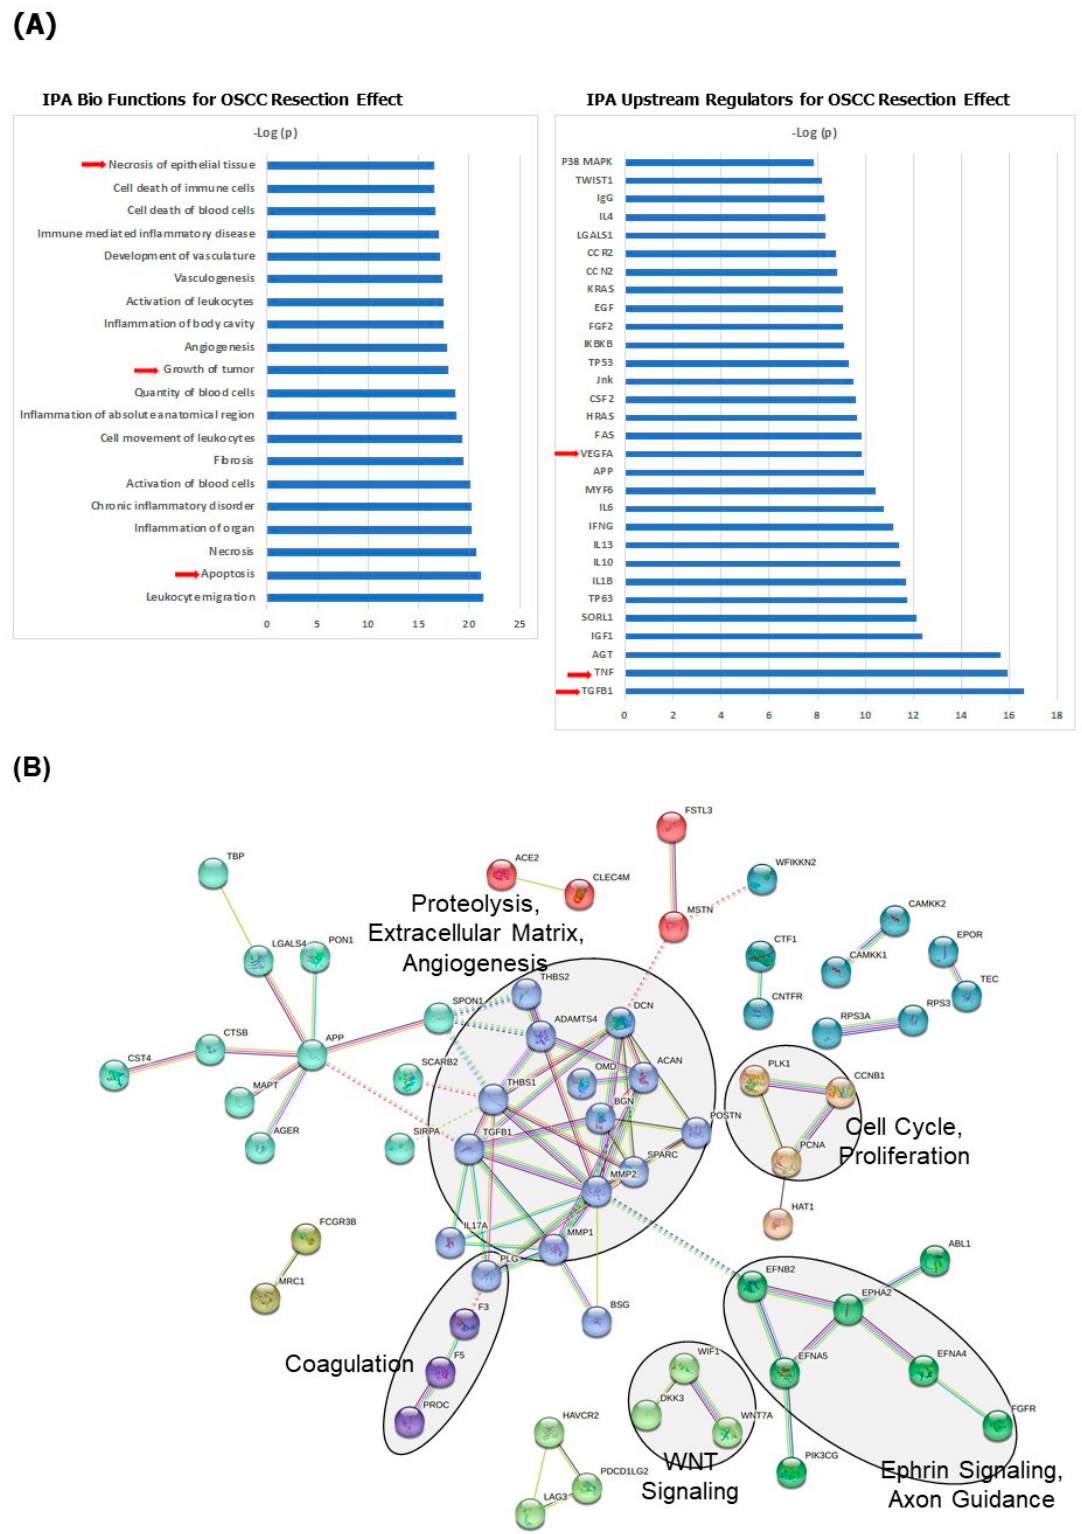
Figure 5. Systems biology analysis of 121 OSCC resection-associated proteins. ( A ) Biological functions that are significantly enriched by the input 121 protein list ( left panel); Upstream regulators that best explain the observed expression changes in response to resection ( right panel). ( B ) Network and cluster analysis using the STRING database of functional and physical protein associations.